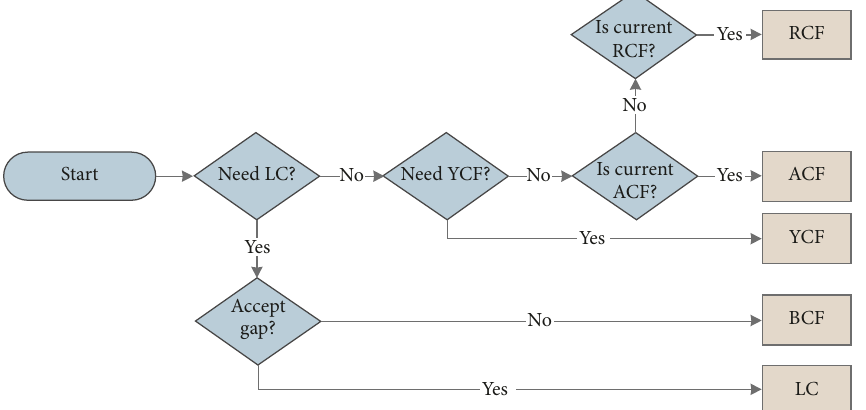
Figure 1: Lane change behavior structure.